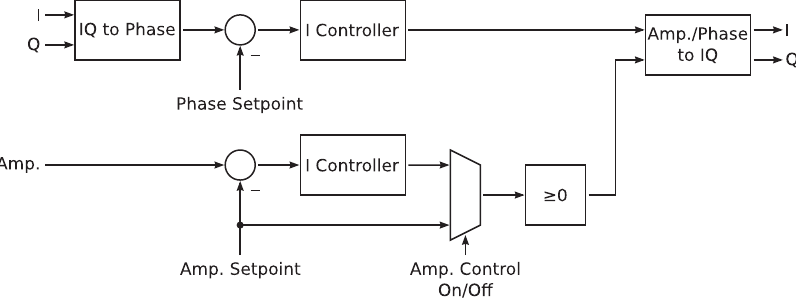
FIG. 2. Simplified flow chart of the generator-driven resonator control algorithm used with the room-temperature cavities. Amplitude and phase of the output signal are generated by the integral